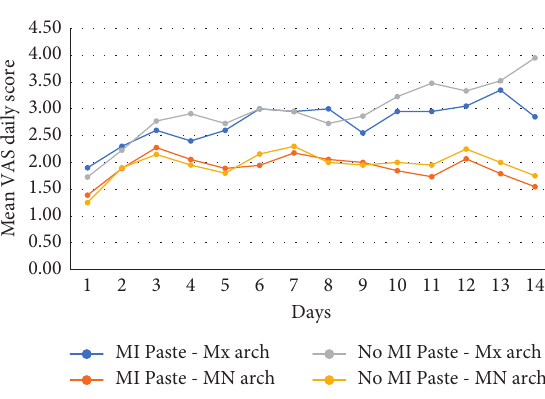
Figure 2: Daily changes in VAS scores. Table 3: Lightness scores at baseline, Time 1, and Time 2 for treatment and control arches.